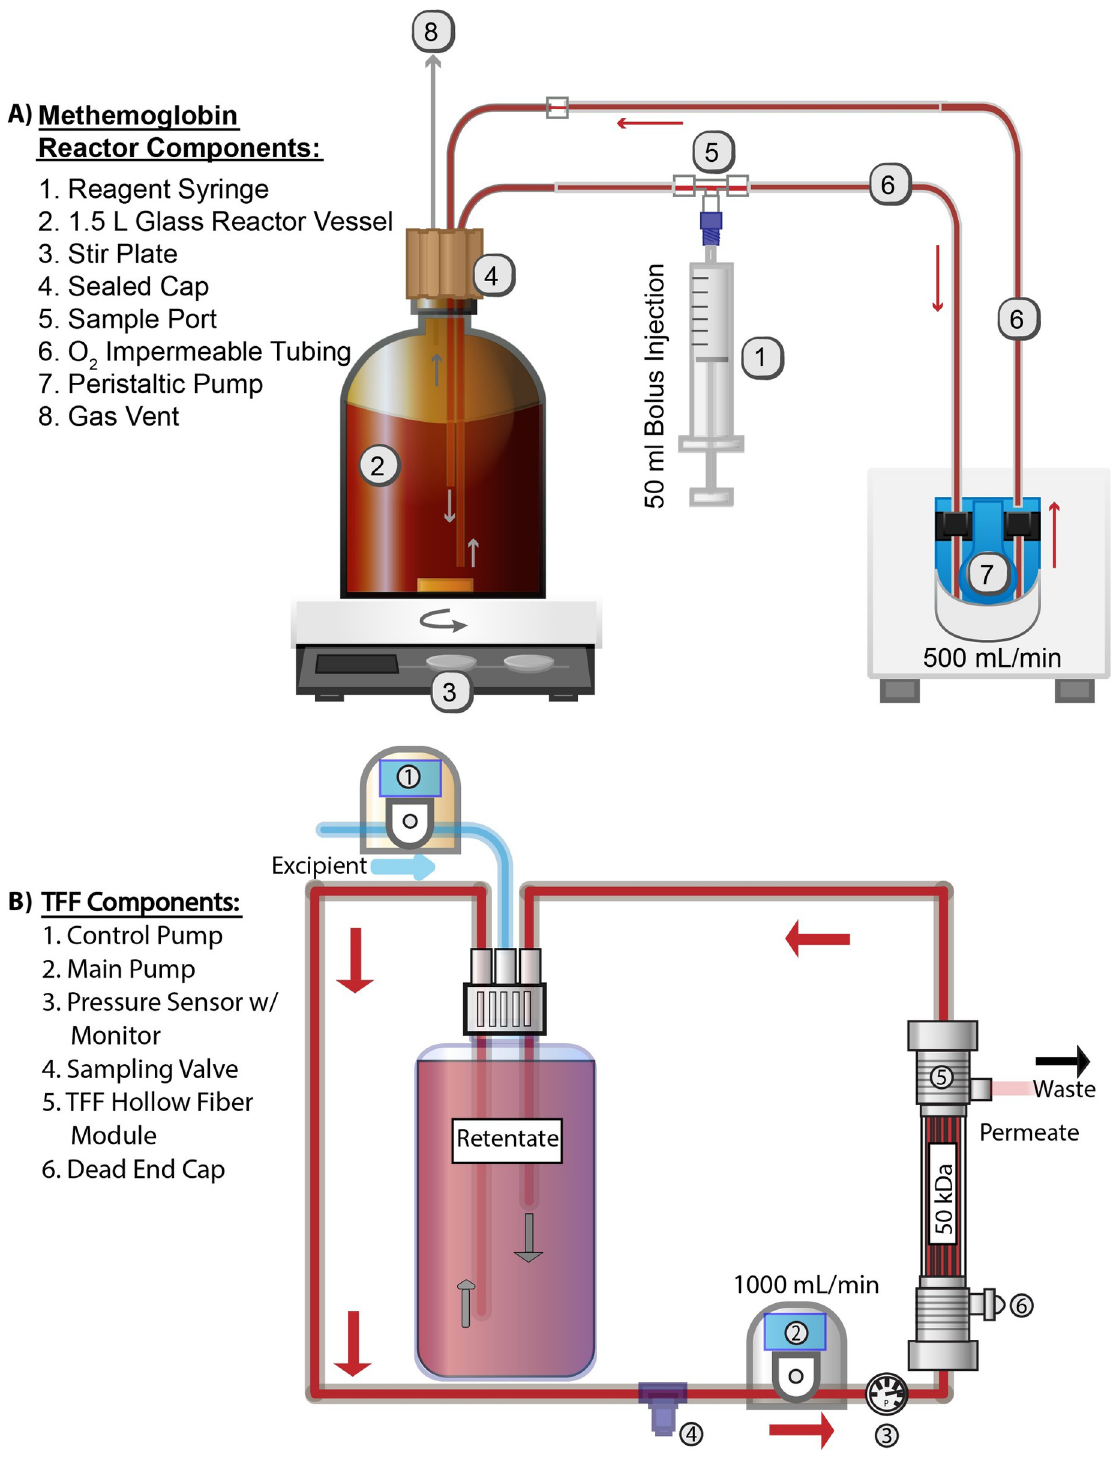
Fig 1. A) Schematic of reactor and fluid recirculation system used to synthesize metHb. B) Schematic of TFF system used to purify